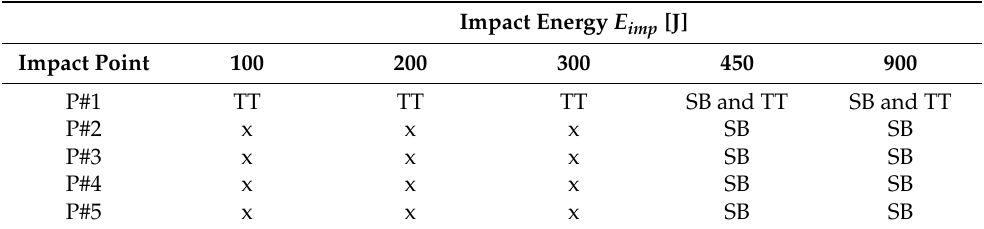
Table 2. Selected experimental configurations. Key: TT = twin tire impactor; SB = spheroconical bag; x = not available.